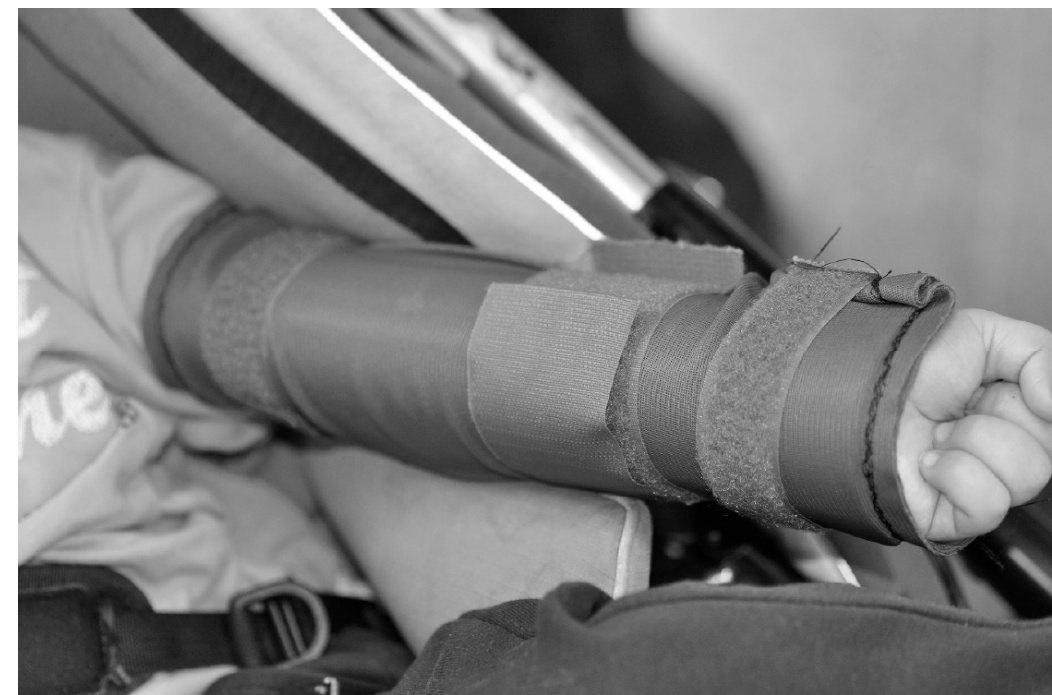
Figure 2. Arm guard.